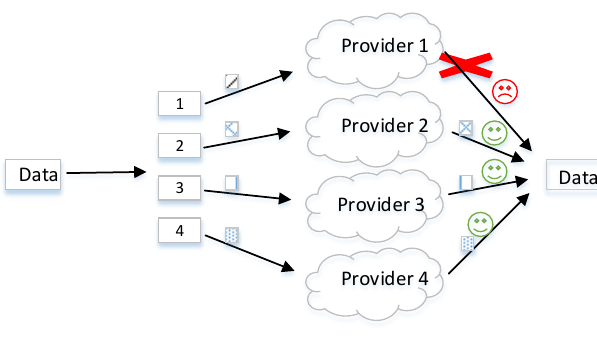
Figure 1. Erasure coding ( 4,3 ) : any 3-subset of the 4 chunks.